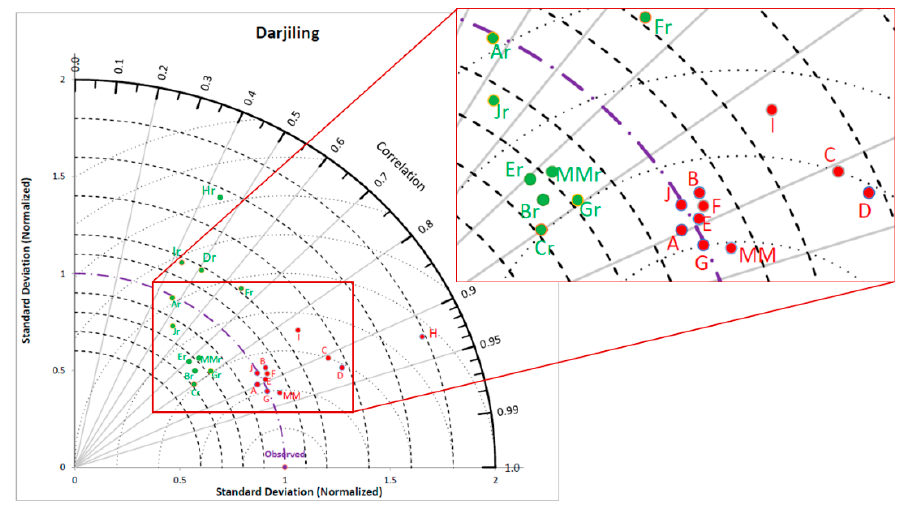
Figure 14. Taylor diagram for downscaling with Re-Obs and GCM-Obs models for Darjeeling. Notations are same as the ones used in Figure 8.